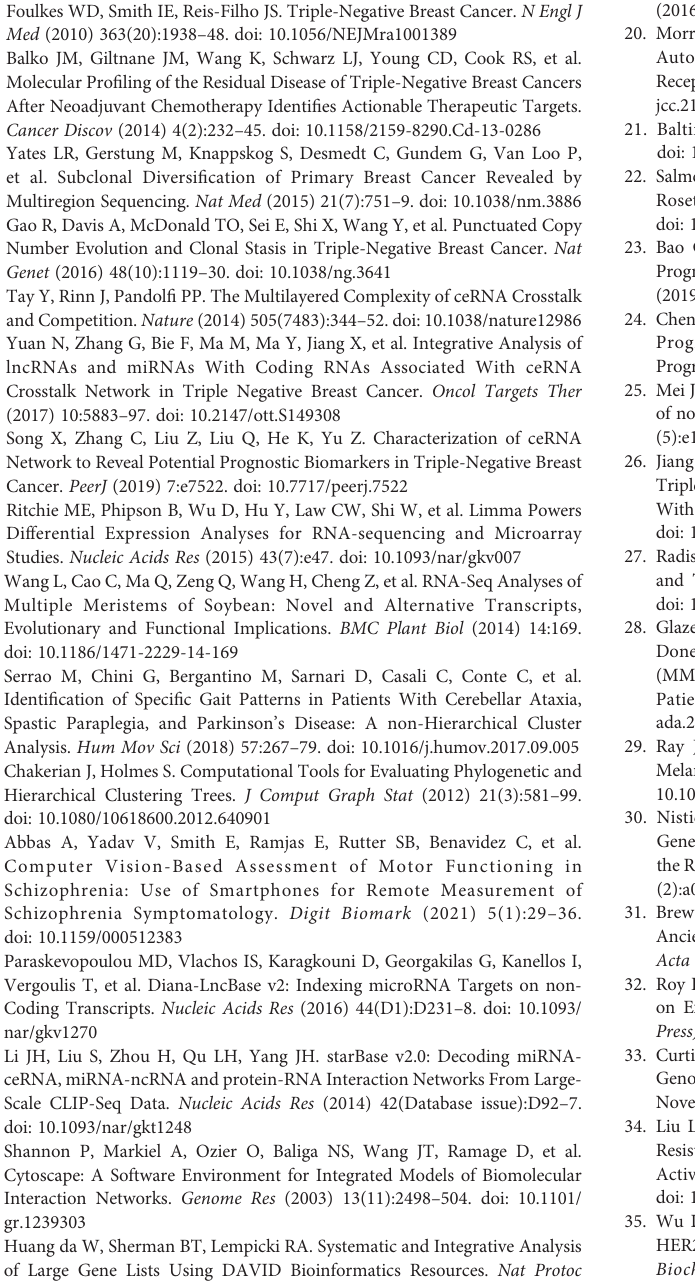
Supplementary Table 7 | Correlation coef fi cient and p value between clinical characteristics and 8 factors. Supplementary Table 8 | Correlation of the PS model characteristic features with small-molecule inhibitors from CTD